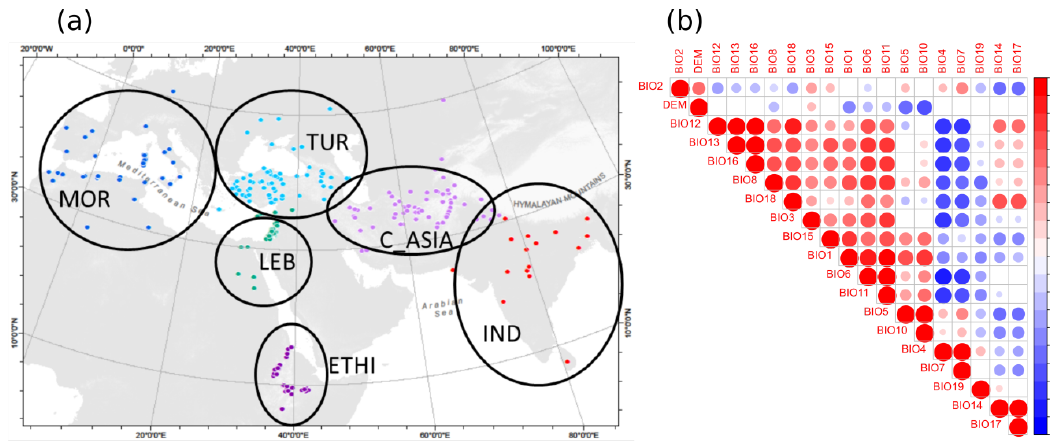
Figure 1. Sample distribution and correlation of bioclimatic variables. ( a ) Location of the chickpea samples around the world that were split into six geographically distinct groups. ( b ) The correlation between nineteen bioclimatic variables (bioclimatic variables and their abbreviations are presented in Table S2). Color intensity and the size of the asterisk are proportional to the correlation coefficients. ETHI, Ethiopia; IND, India; LEB, Lebanon; MOR, Morocco; TUR, Turkey; C_ASIA, Central Asia.